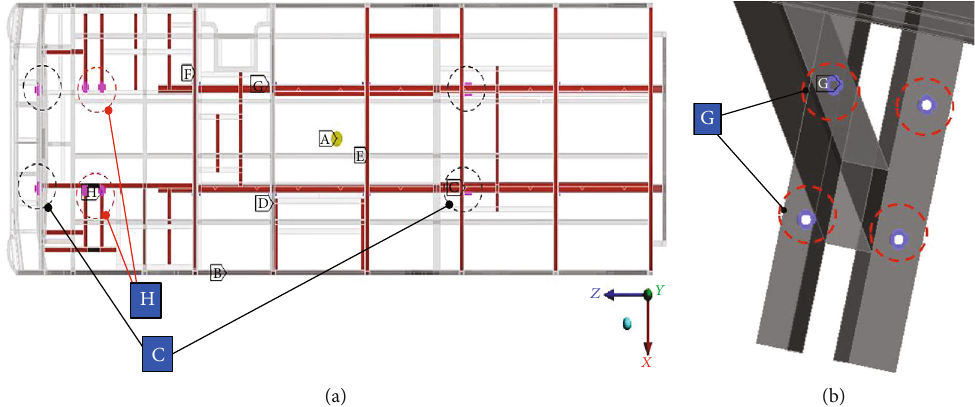
Figure 5: Fixed constraints through a pure bending case: (a) support C and H and (b) support